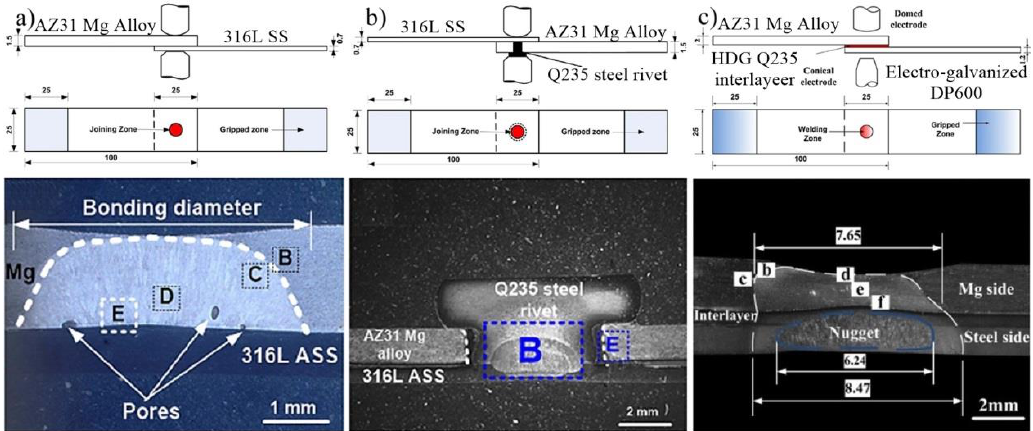
Figure 25. Mg/steel RSW process [84,85] ( a ) schematic diagram of the traditional RSW process and cross-section of the weld; ( b ) schematic diagram of the REW process and cross-section of the weld; ( c ) schematic diagram of RSW with Q235 interlayer process and cross-section of the weld.